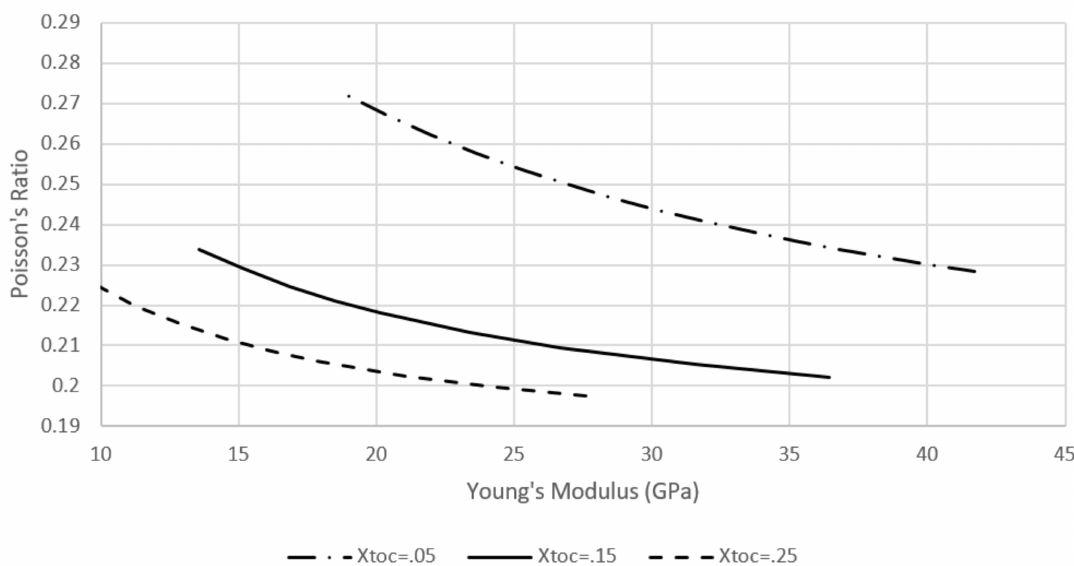
Figure 10. Relationships between Poisson’s ratio and Young’s modulus. Equations (9)–(12) are used to show the dependence of the relationship between these moduli on the volume fraction of TOC. Lines are for constant TOC volume fractions (X TOC ) of 0.25 (dashed line), 0.15 (solid line), and 0.05 (dot-dash line) from the regression Equations (9) and (10) and elastic moduli relationships (11) and (12). These trends represent average shale reservoir properties in our dataset and may vary somewhat in any given